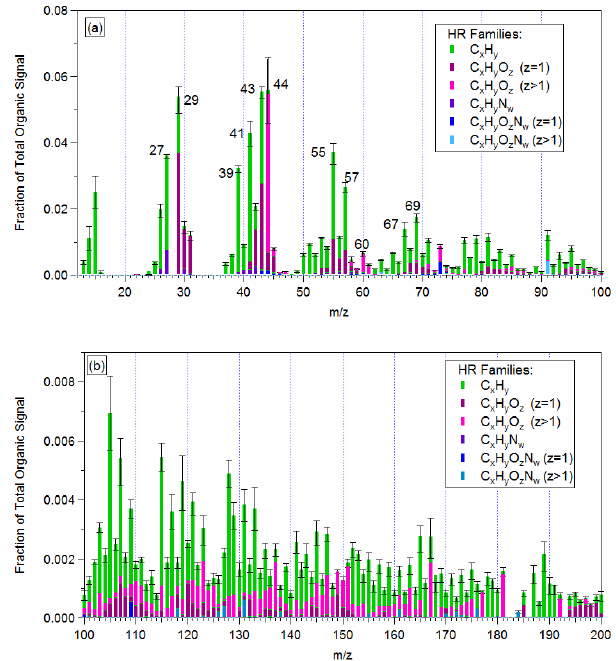
Figure 2. Average of fresh organic mass spectra of the 4 source characterization experiments: (a) the mass spectra from m/z’s 1 to 100 and (b) from m/z’s 101 to 200 . The black bars correspond to one standard deviation of the total amount at each m/z .